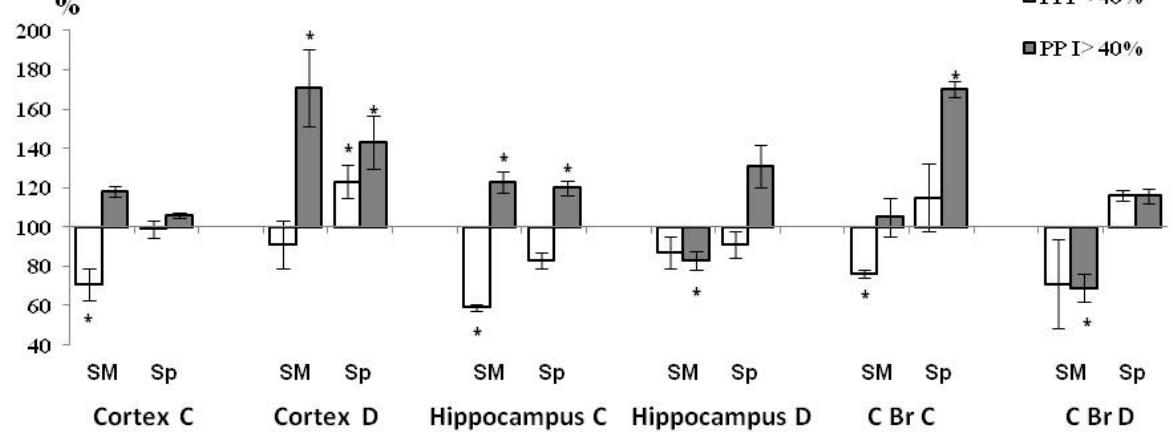
Figure 3. Effect of HBH on ChAT activity in synaptic sub-fractions in the HBH sub-groups in rats with PPI< and >40% 4 min